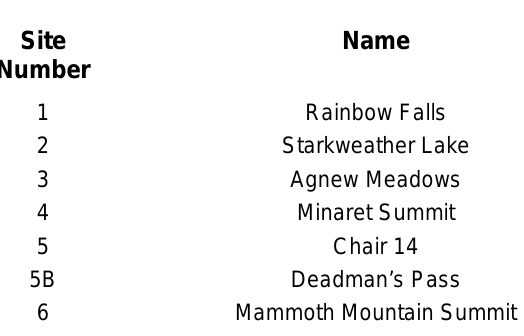
Location and Elevation of Monitoring Sites on Mammoth